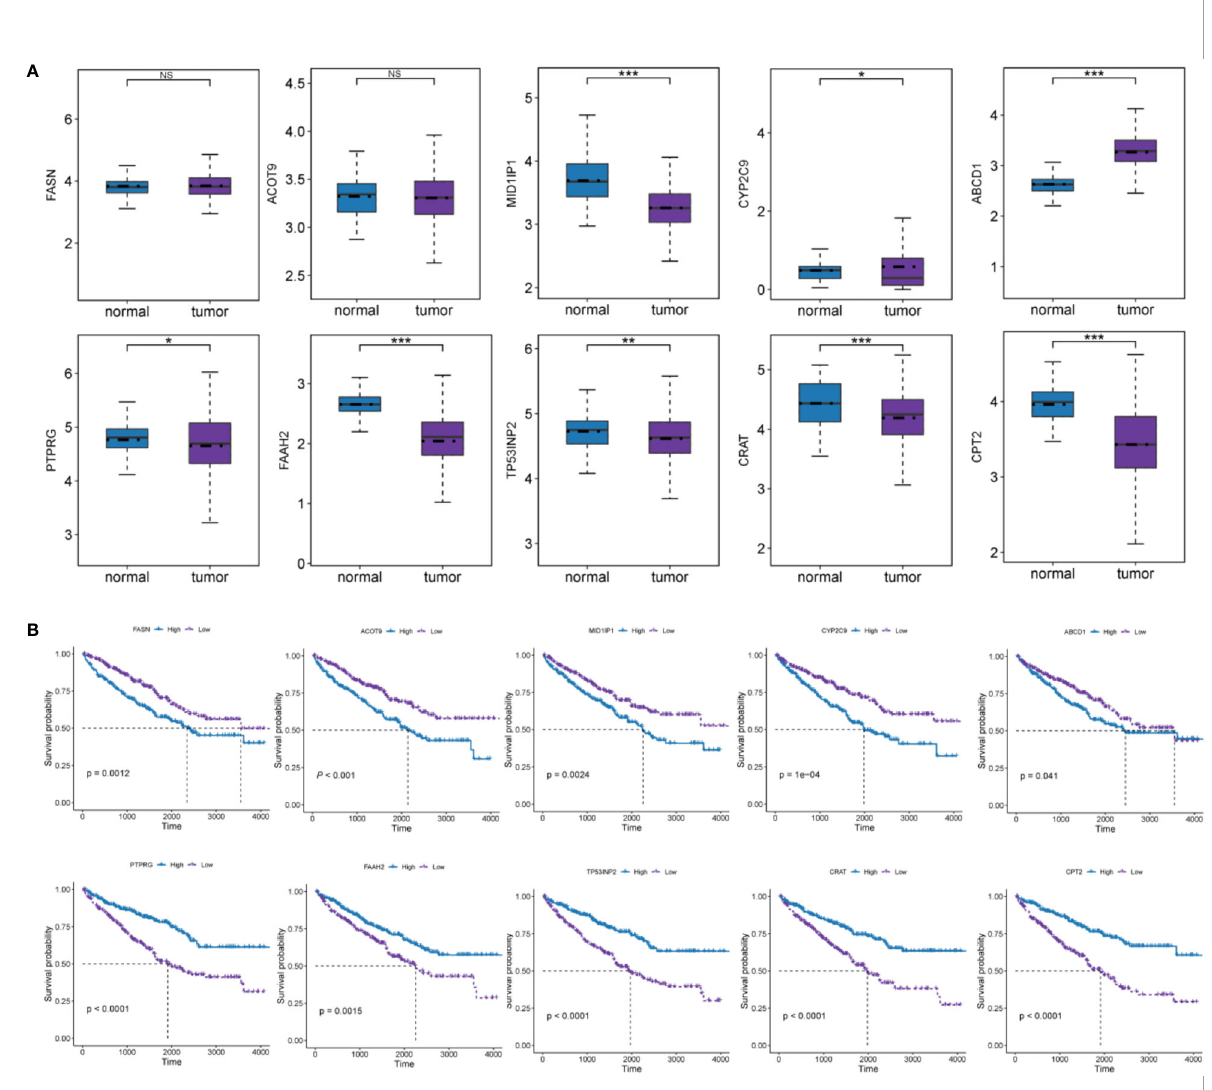
FIGURE 2 Analyses of the effect of expression levels of each of the 10 FMGs in the signature on prognosis. (A) Expression level of the 10 prognostic FMGs in tumor and normal samples. (B) K-M overall survival curves of ccRCC patients according to relative expression of the 10 FMGs. * P < 0.05; ** P < 0.01; *** P < 0.001; ns means no signi fi